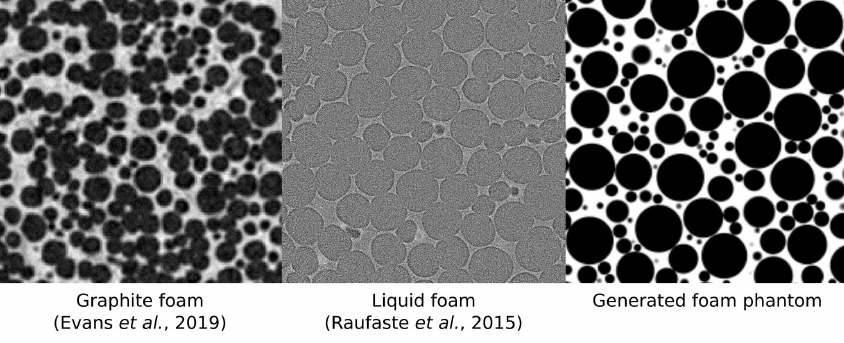
Figure 1 Two examples of X-ray computed tomography images of foam samples (left, middle), and an example of a computer-generated phantom from the proposed foam phantom family (right). In all three images, a cropped region of the entire sample is shown. A graphite foam sample (Evans et al. , 2019; Evans, 2019) is shown on the left, and a liquid foam sample (Raufaste et al. , 2015), available at Tomobank (De Carlo et al. , 2018), is shown in the